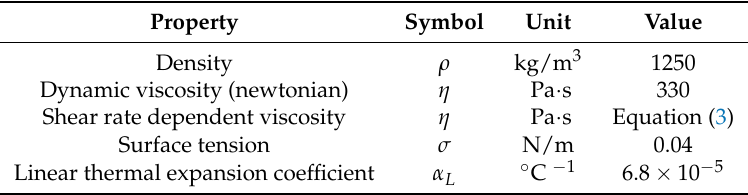
Table 2. PLA properties used in the